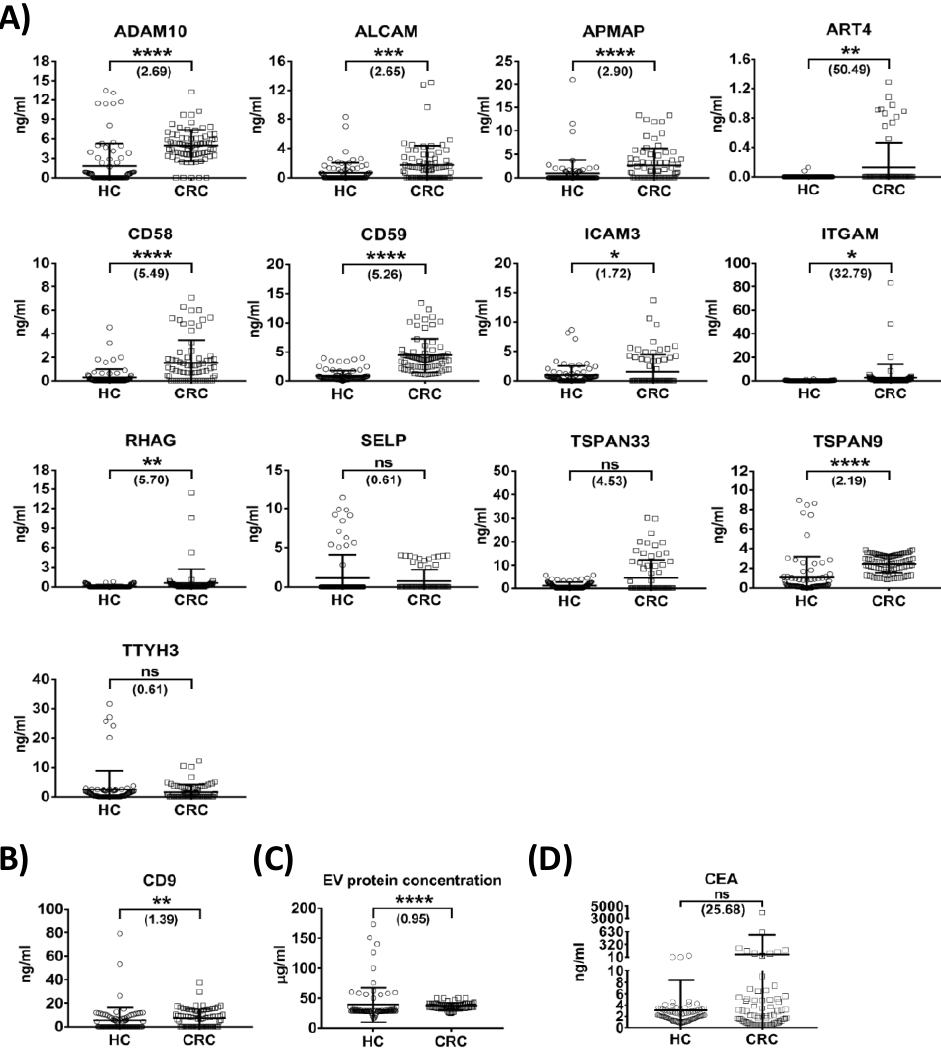
Figure 5. Measurement of protein levels of 13 targets and CD9, and EV total protein concentration, in plasma EVs from enrolled subjects. ( A – C ) Levels of 13 target proteins ( A ), CD9 ( B ), and EV total protein concentration ( C ) in plasma EV fractions from HCs and CRC patients. ( D ) Levels of CEA measured in plasma specimens from HC and CRC patients. Horizontal lines indicate means ± S.D.